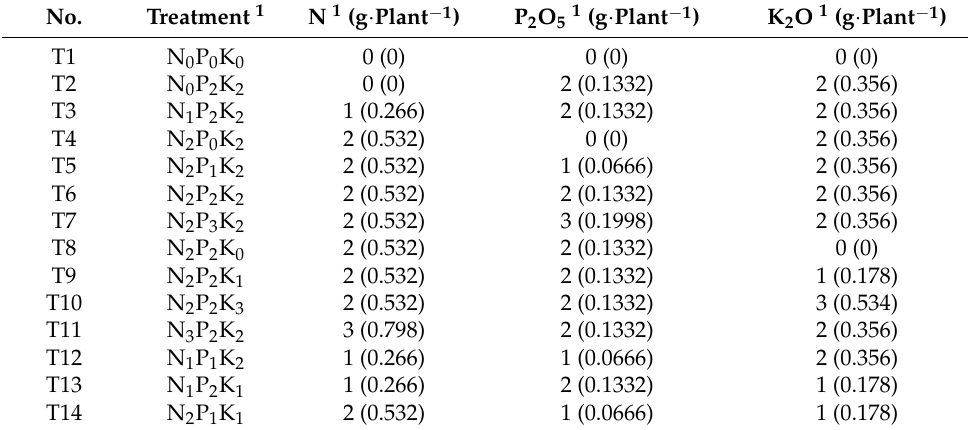
Table 6. The “3414” fertilization experiment rates